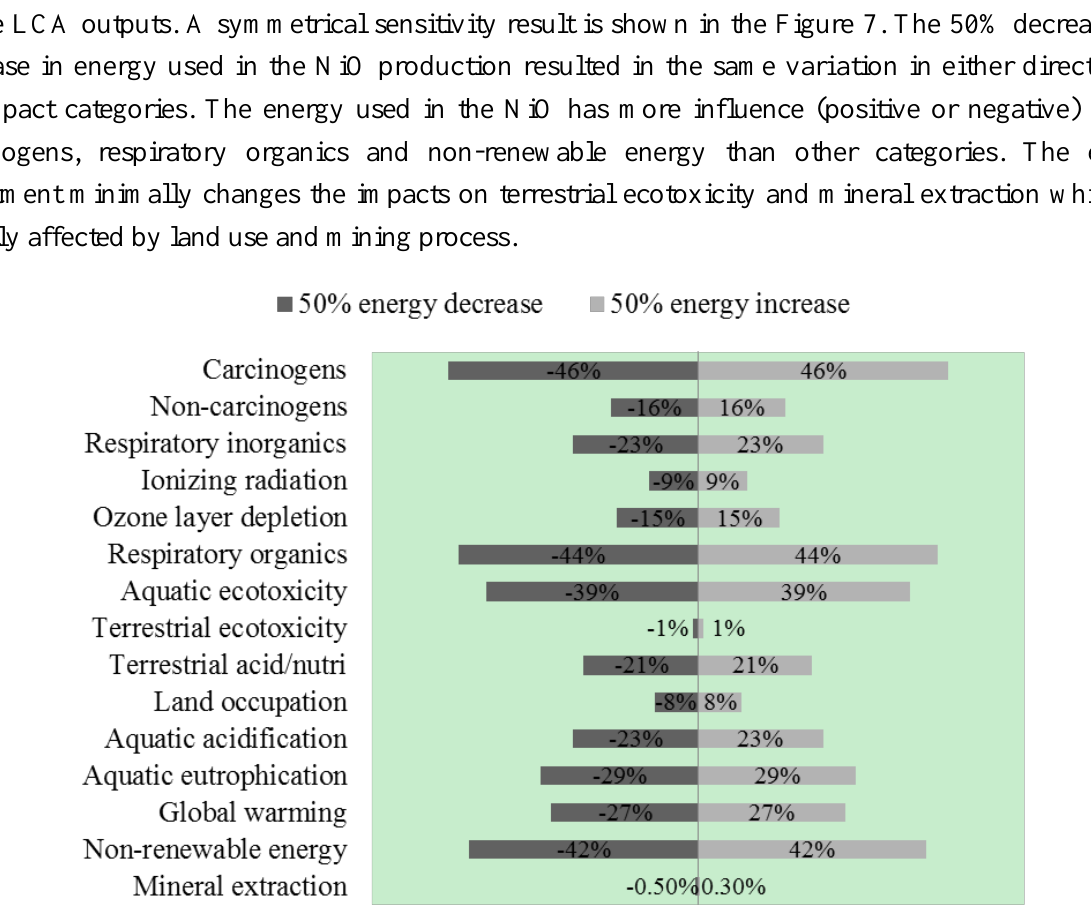
Figure 7. Energy used adjustment in NiO